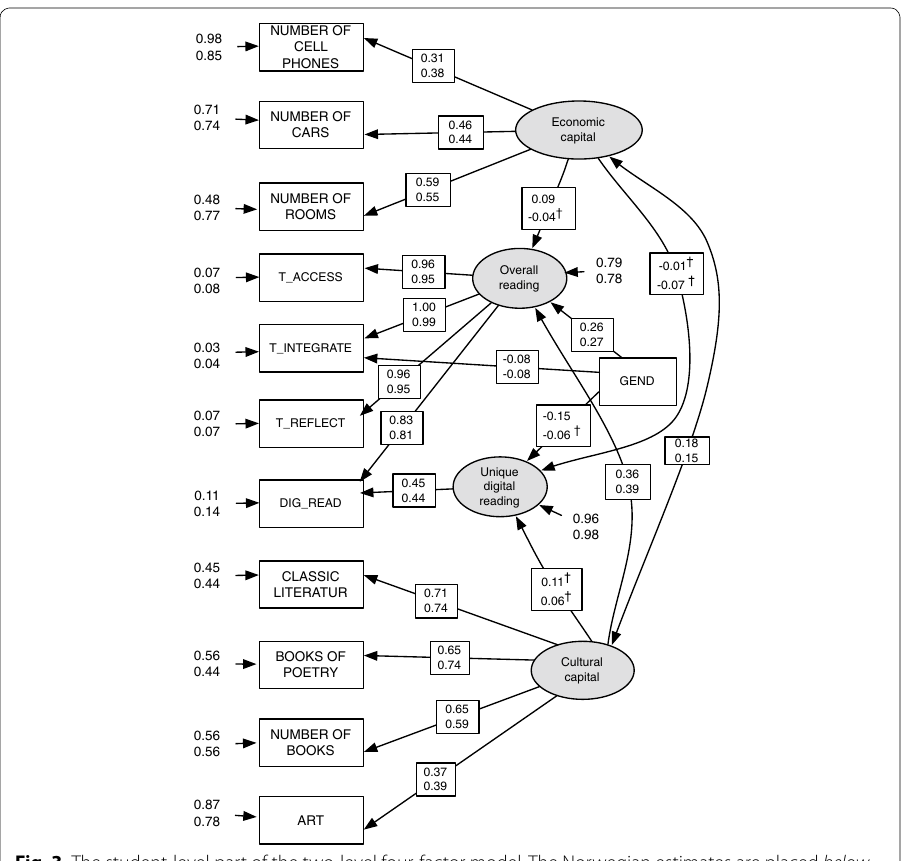
Fig. 3 The student-level part of the two-level four-factor model. The Norwegian estimates are placed below the Swedish estimates. A dagger indicates a non-significant